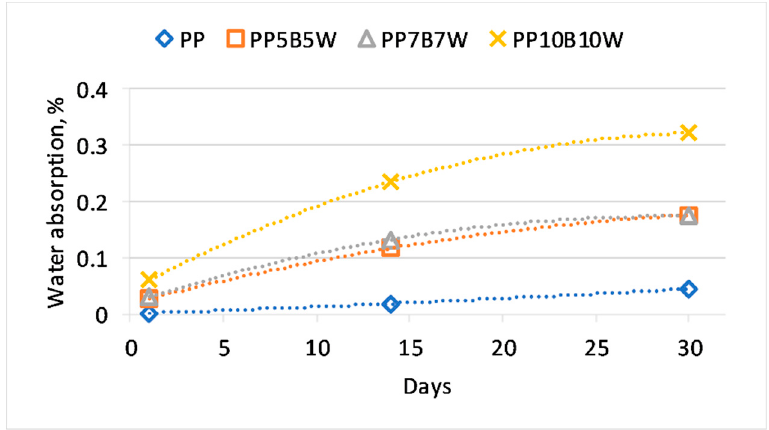
10 of 14 Figure 6. Thermal expansion curves of the tested composites. Table 4. Linear coefficient of thermal expansion of tested materials. Sample